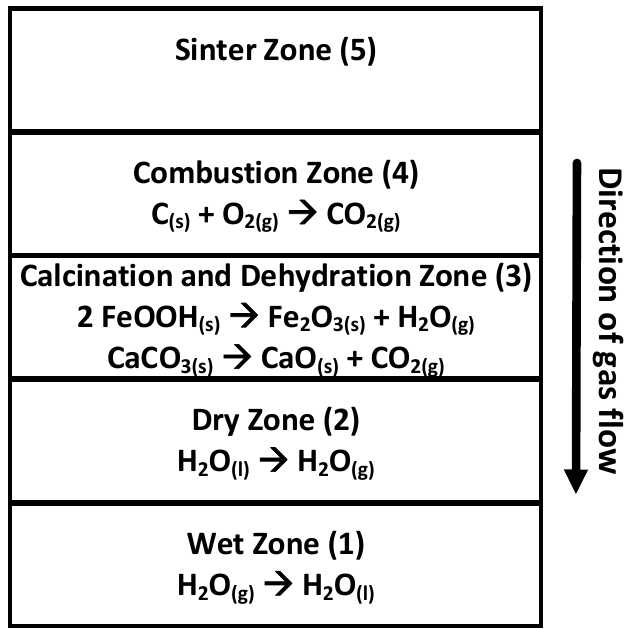
Figure 1. Zones within a downdraught sinter bed during sintering [2,3].